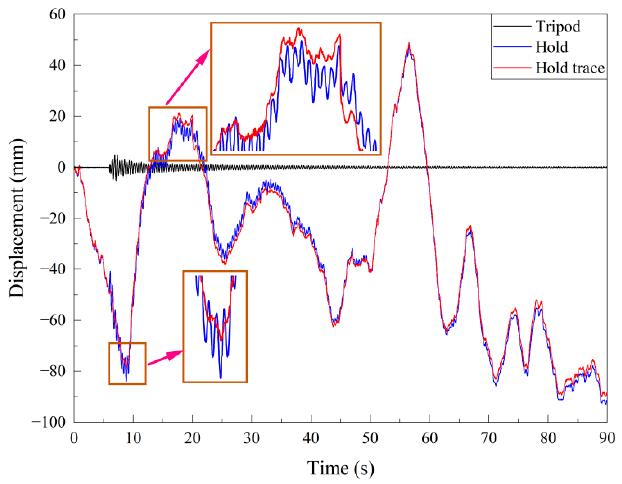
Figure 13. Displacement time history comparison in the state of standing hold smartphone shooting.